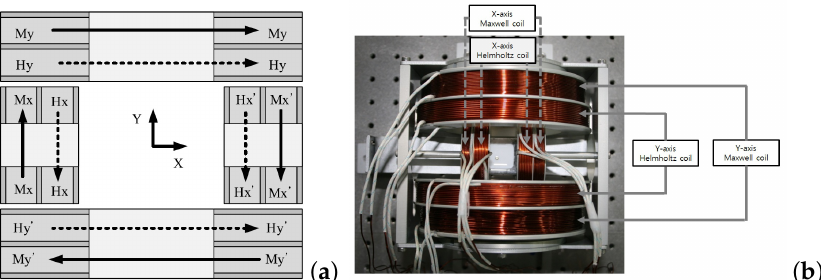
Figure 9. 2H2M EMA platform developed by Choi et al. [65]: ( a ) scheme of the concept; and ( b ) a photograph of the built